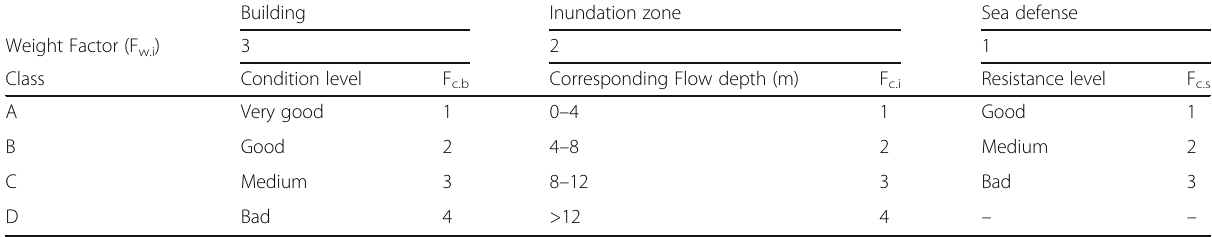
Table 2 Criteria considered to control the tsunami buildings vulnerability, their corresponding weight factors (F w.i ) and classification factors (F c.b for building condition, F c.i for inundation zone, and F c.s for sea defense) Building Inundation zone Sea defense Weight Factor (F w.i